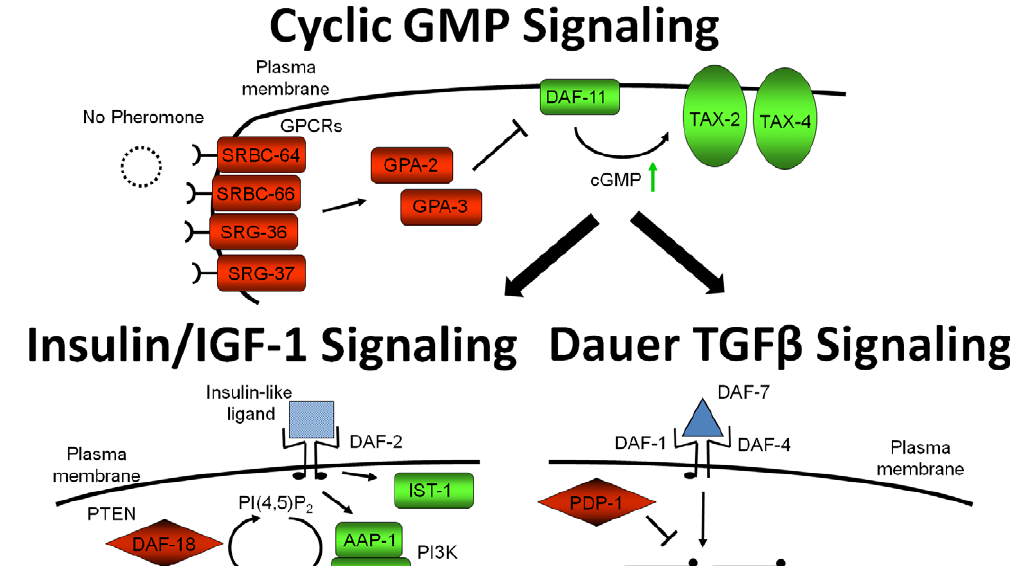
Bowtie aligner version 0.12.7 (http://bowtie-bio.sourceforge.net/